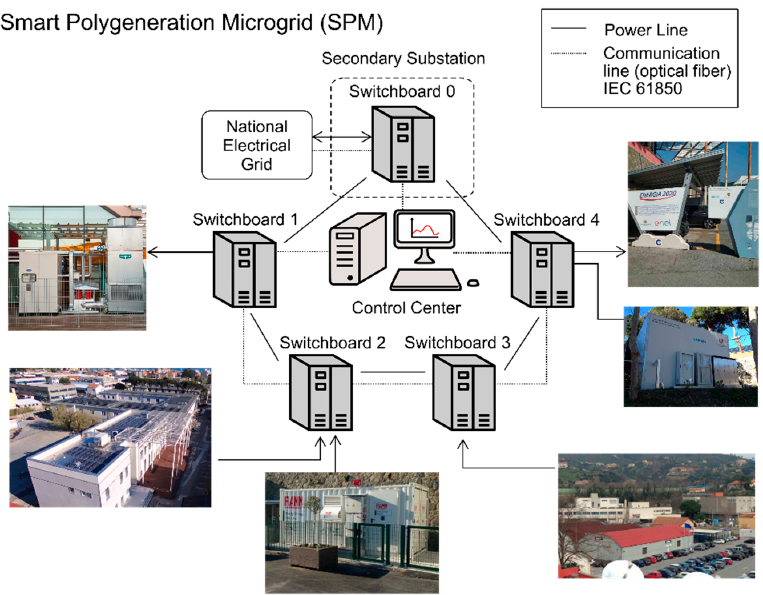
Figure 9. Smart Polygeneration Microgrid (SPM).